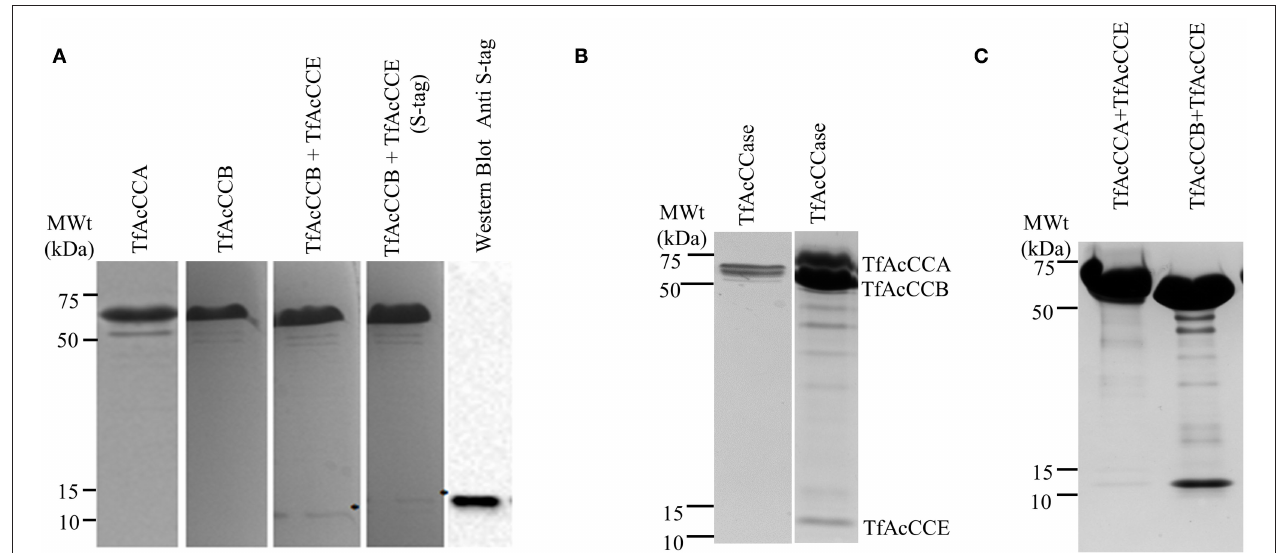
FIGURE 1 | SDS-PAGE analysis of purified TfAcCCase and component subunits. (A) Each lane is loaded with purified preparations of the indicated purified subunits. Left to right: TfAcCCA (62.1 kDa), TfAcCCB (57.6 kDa), co-expressed TfAcCCB and TfAcCCE (8.7 kDa), and co-expressed TfAcCCB and S-tagged TfAcCCE. (B) Analysis of purified complex assembled by the co-expression of TfAcCCA, TfAcCCB, and TfAcCCE. Complexes were purified by affinity chromatography with a nickel affinity column via the His-tag carried by the TfAcCCB subunit. In order to visualize the presence of the TfAcCCE subunit in the purified complex, the right lane was loaded with 6 times more protein than the left lane. (C) Assembly of TfAcCCE into complexes with either His-tagged TfAcCCA or His-tagged TfAcCCB. Complexes were purified by affinity chromatography with a nickel affinity column via the His-tagged subunit and subjected to size-exclusion chromatography prior to SDS-PAGE analysis. Proteins were visualized by staining the resulting gels with Coomassie Brilliant Blue or visualized by Western analysis using anti-S-tag